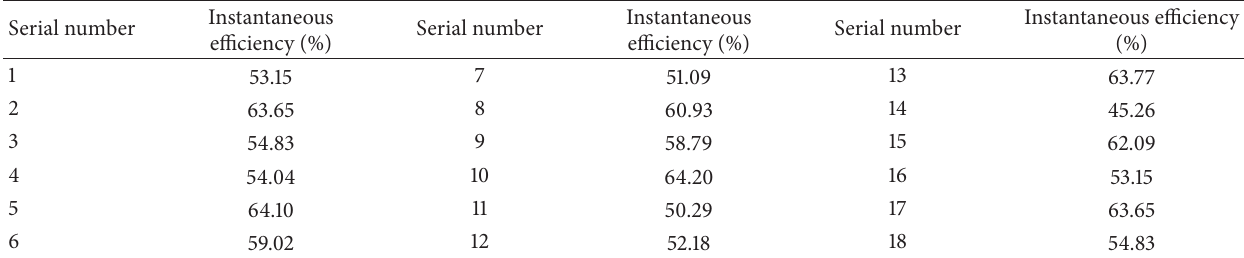
Table 4: The experimental results of instantaneous efficiency.